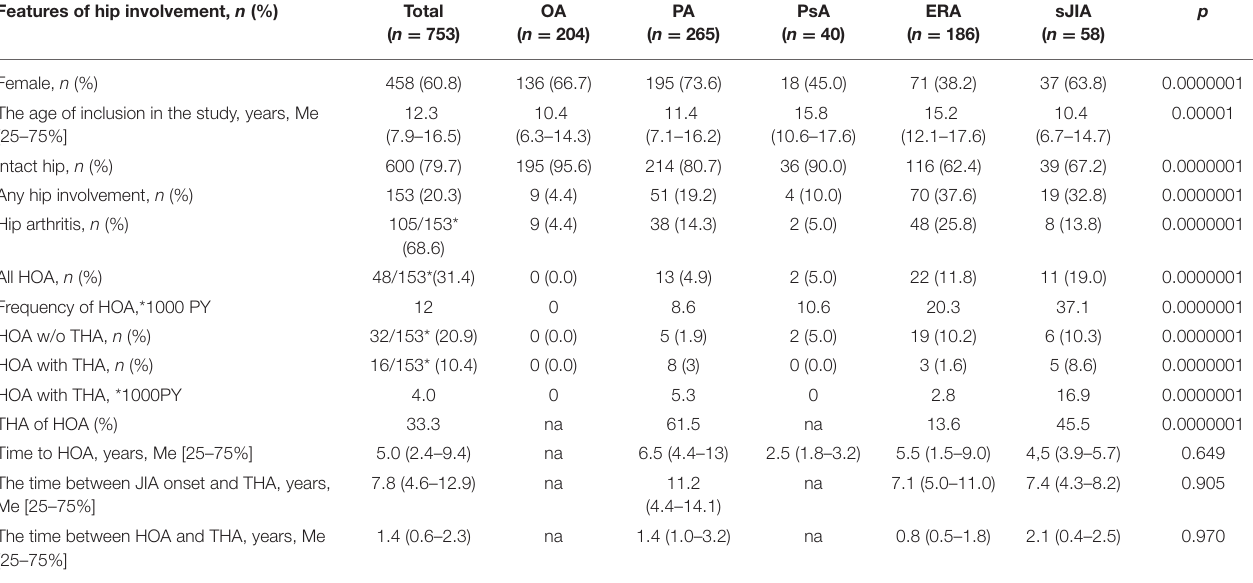
TABLE 1 | Hip involvement in children with JIA categories. Features of hip involvement, n